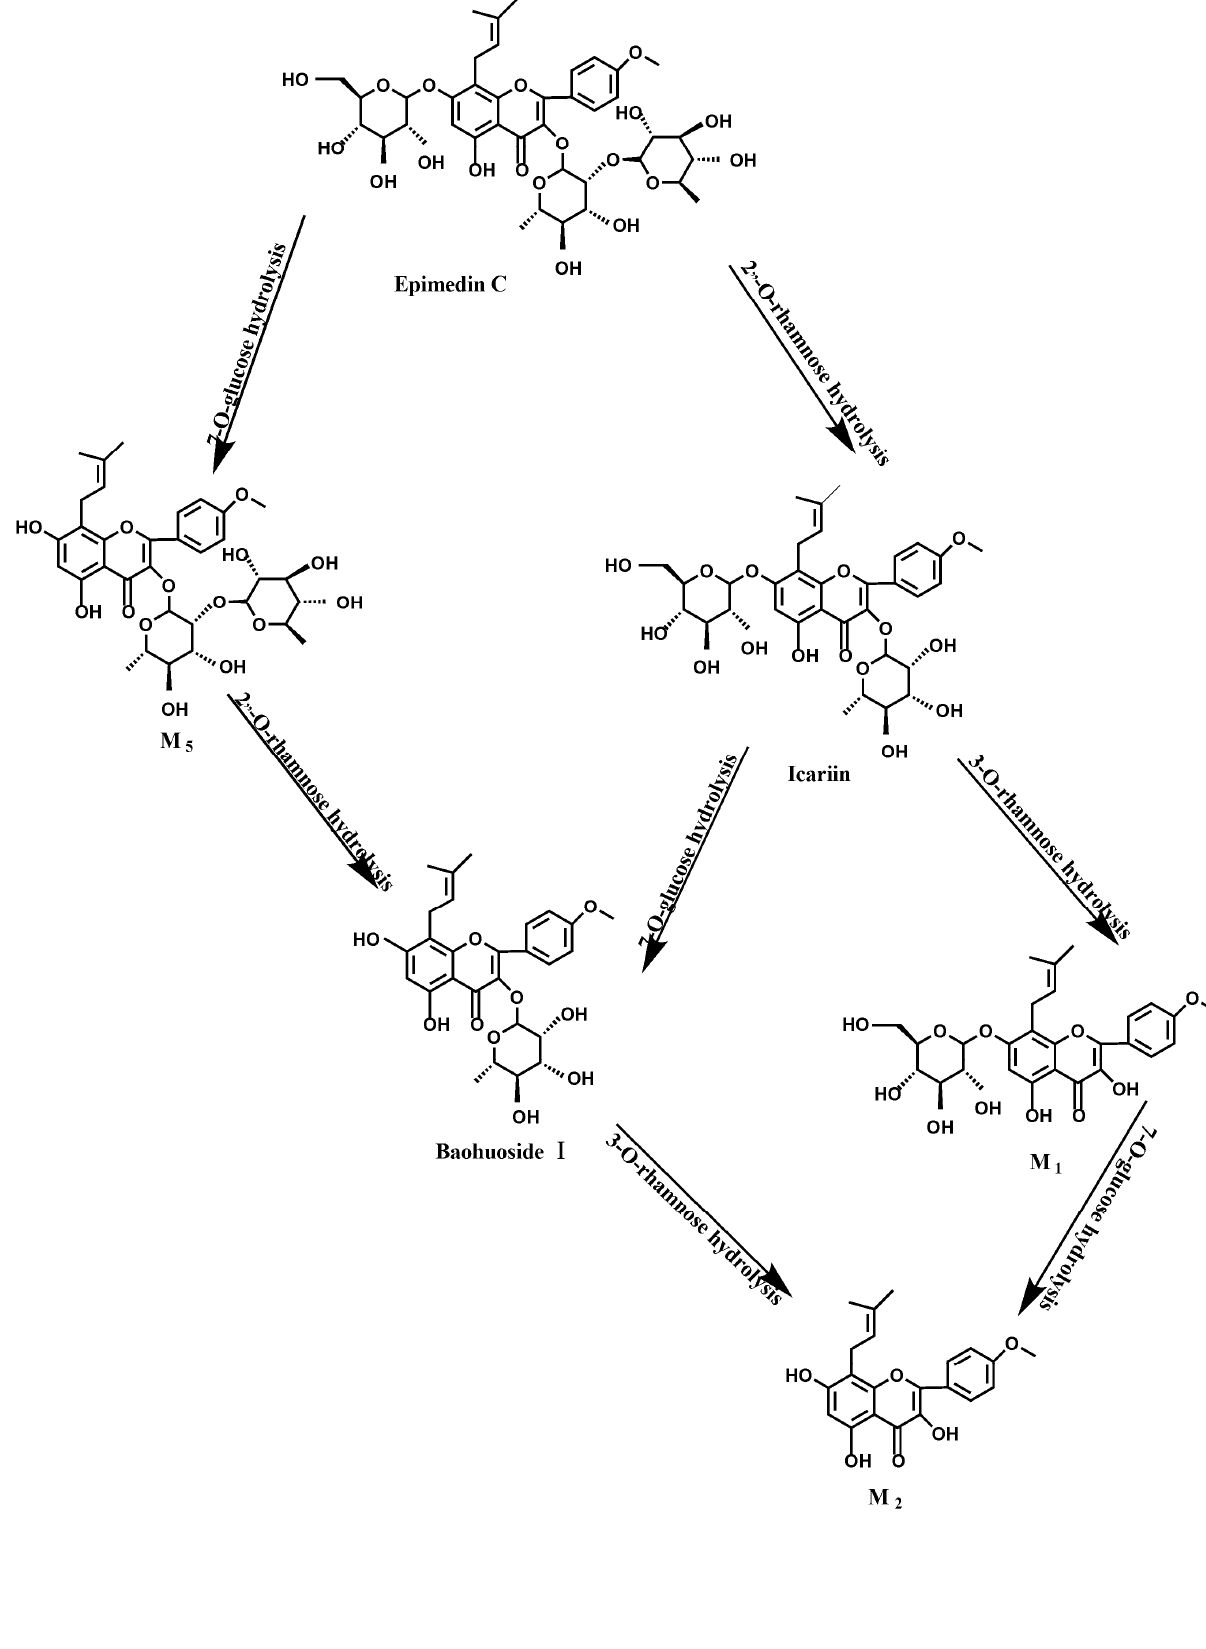
Figure 14. The metabolic pathway of epimedin C in intestinal flora and enzyme of